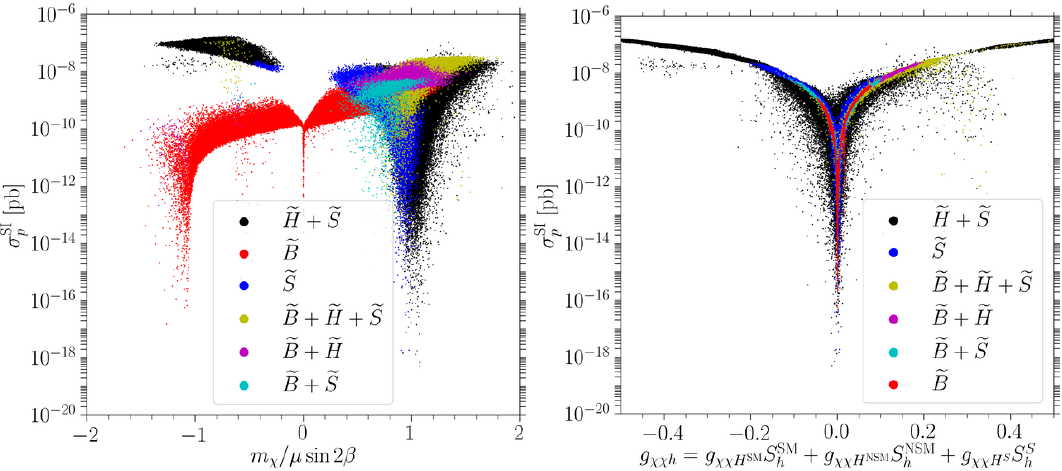
Figure 5 . Left: the SIDD cross section (cid:27) SI for the points passing the required experimental collider p constraints vs. m (cid:31) = ( (cid:22) sin 2 (cid:12) ), where the blind-spot conditions are satis(cid:12)ed for m (cid:31) = ( (cid:22) sin 2 (cid:12) ) = +1( (cid:0) 1) for the singlino-Higgsino (bino-Higgsino) case. Right: the spin independent cross section for the same points vs. the coupling of the DM candidate to the SM-like Higgs mass eigenstate. The color coding is the same as if (cid:12)gure 3.